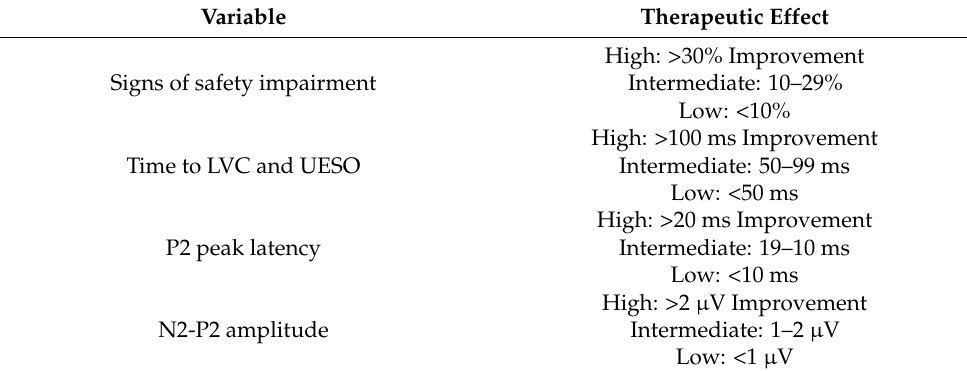
Table 5. Criteria to determine the intensity of the therapeutic effect. Variable Therapeutic Effect Signs of safety impairment Time to LVC and UESO